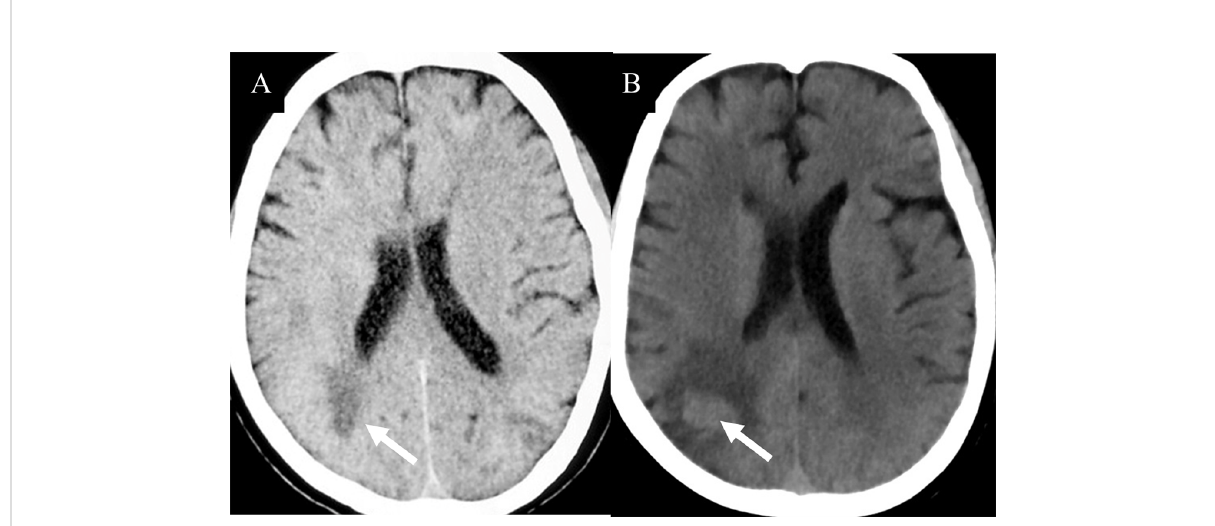
FIGURE 1 (A) Isodense lesion (white arrow) were detected on CT during an early disease. (B) One months later, brain lesions appeared hyperintense (white arrow). Pathological examinations indicated a diagnosis of PCNSL.